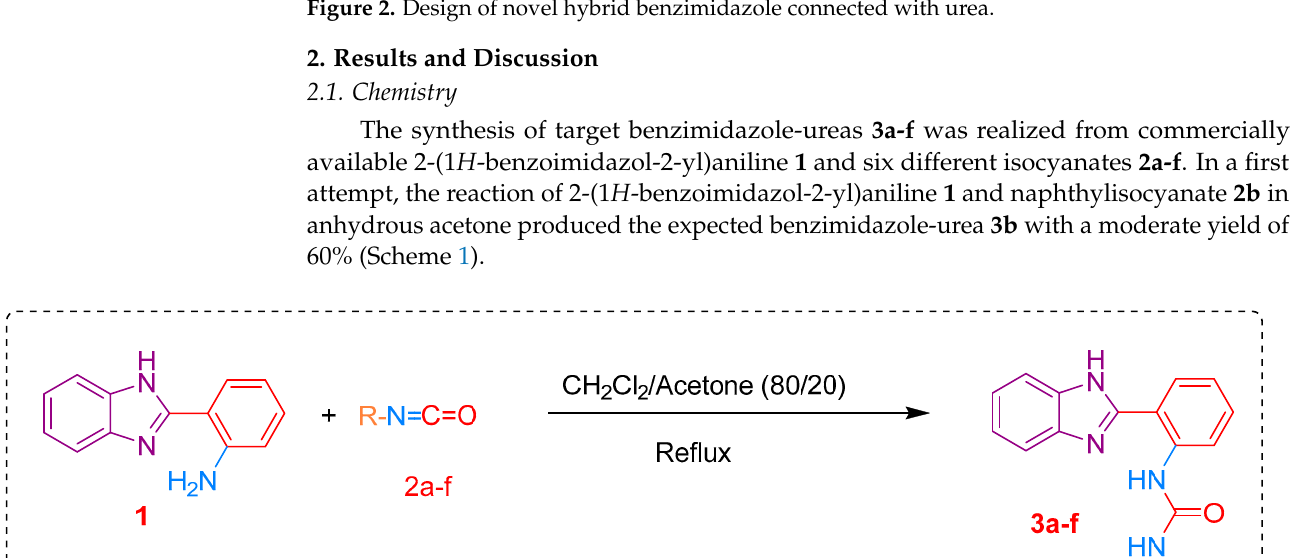
Figure 2 . Design of novel hybrid benzimidazole connected with urea. Figure 2. Design of novel hybrid benzimidazole connected with